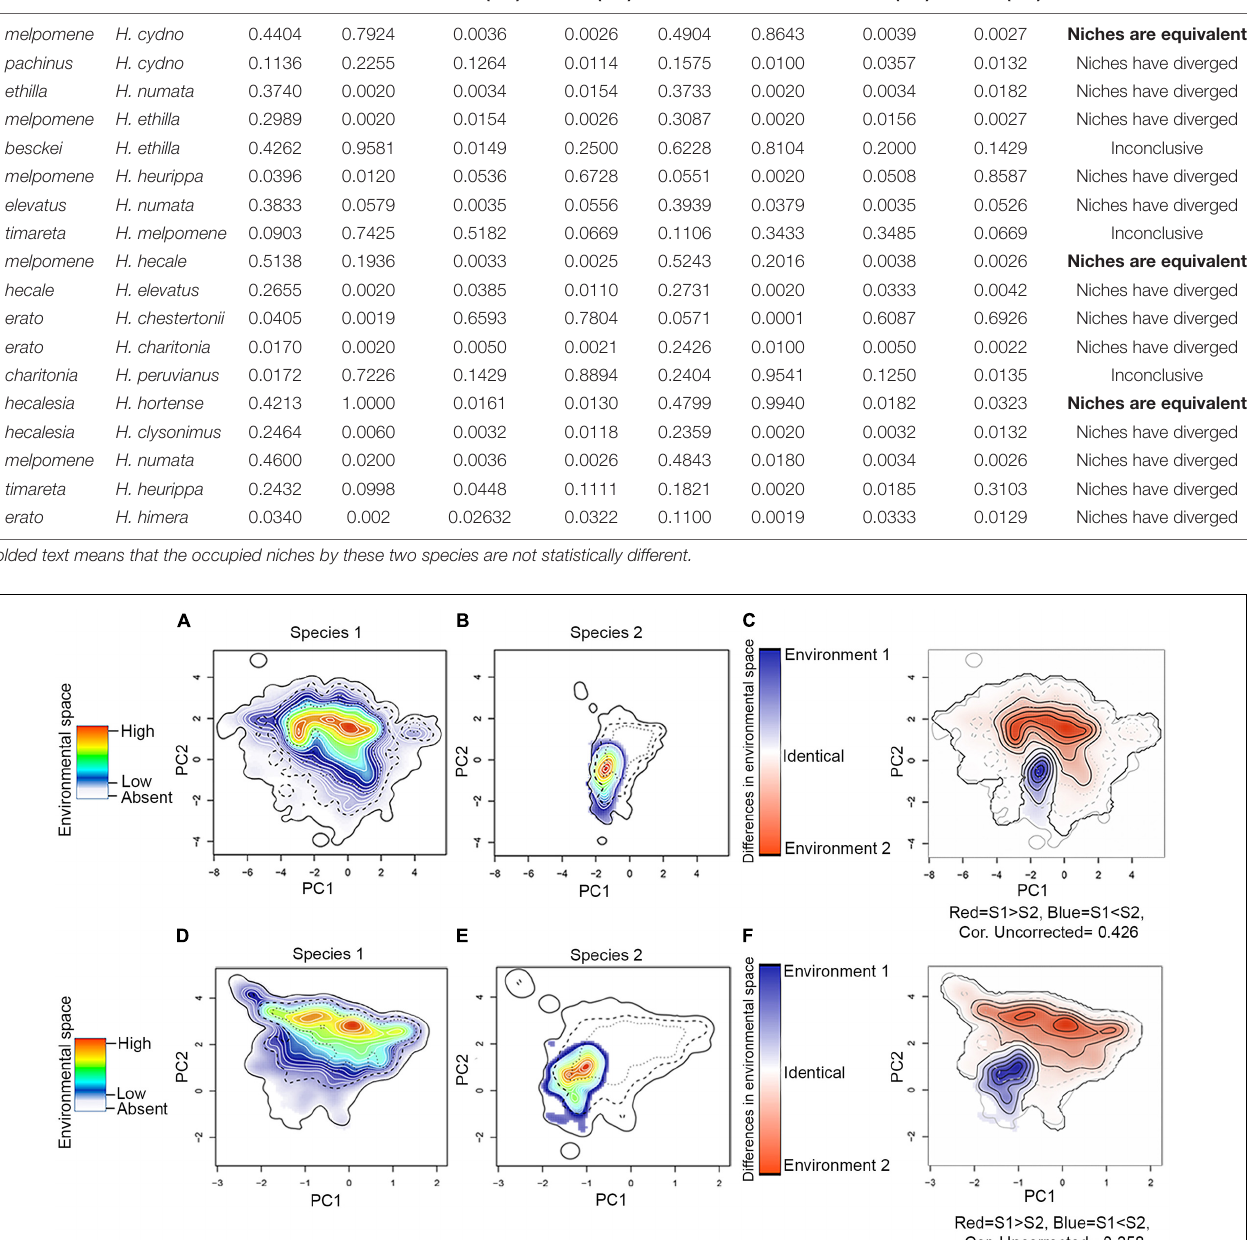
Frontiers in Ecology and Evolution |